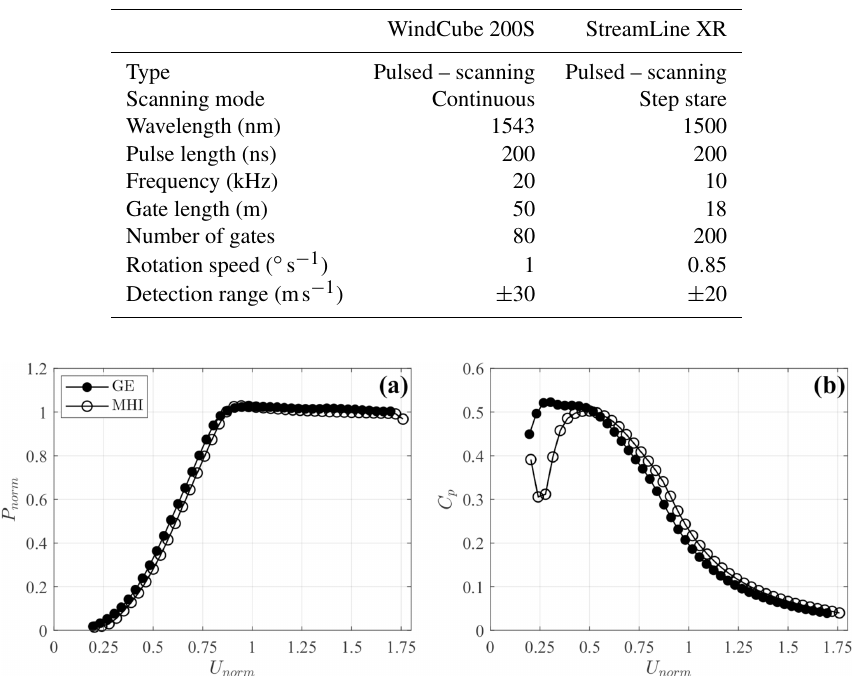
Figure 3. Performance curves for the General Electric (GE) and Mitsubishi (MHI) wind turbines. (a) Normalized power, P norm , and (b) power coefficient, C p